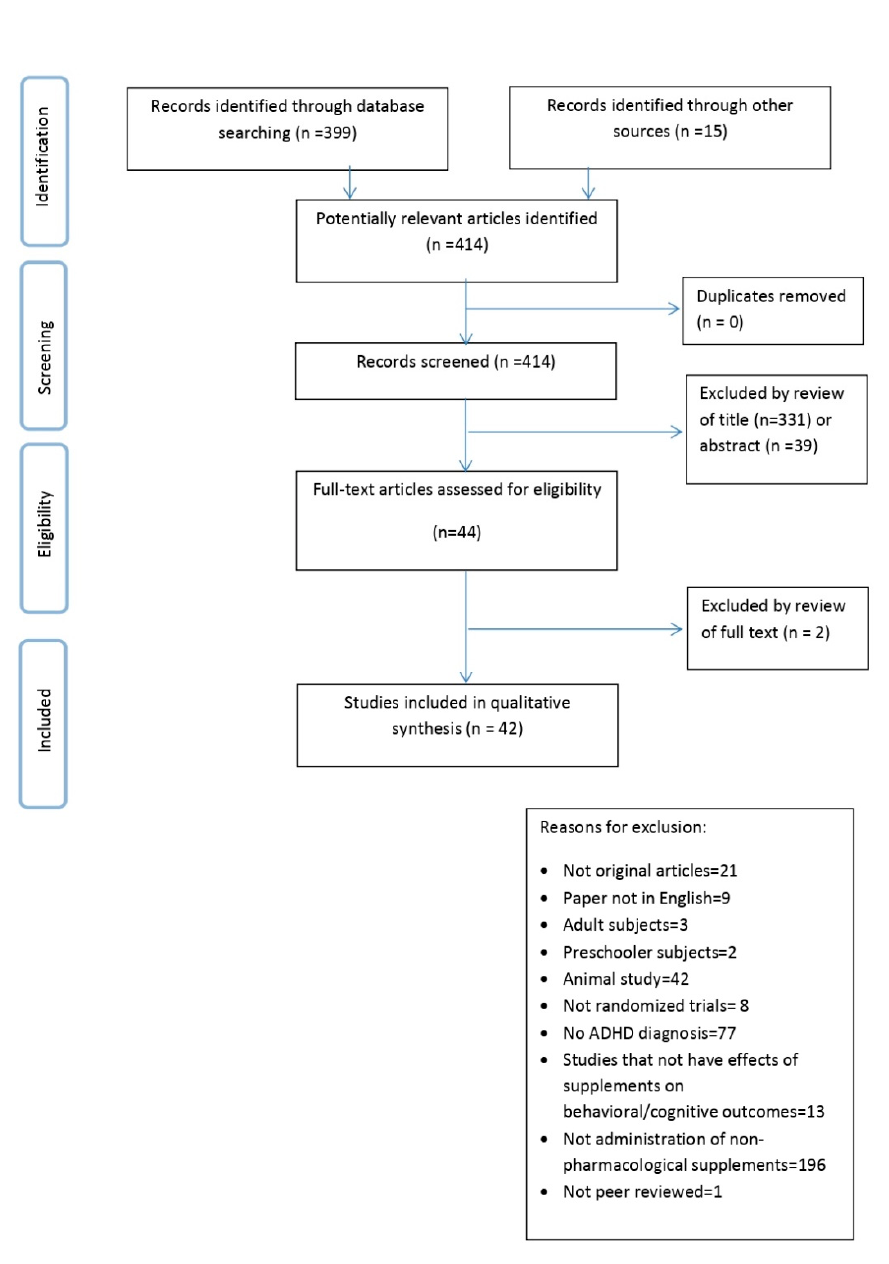
Figure 1. Preferred reporting items for systematic reviews and meta-analyses (PRISMA).Flow diagram of the study selection process.